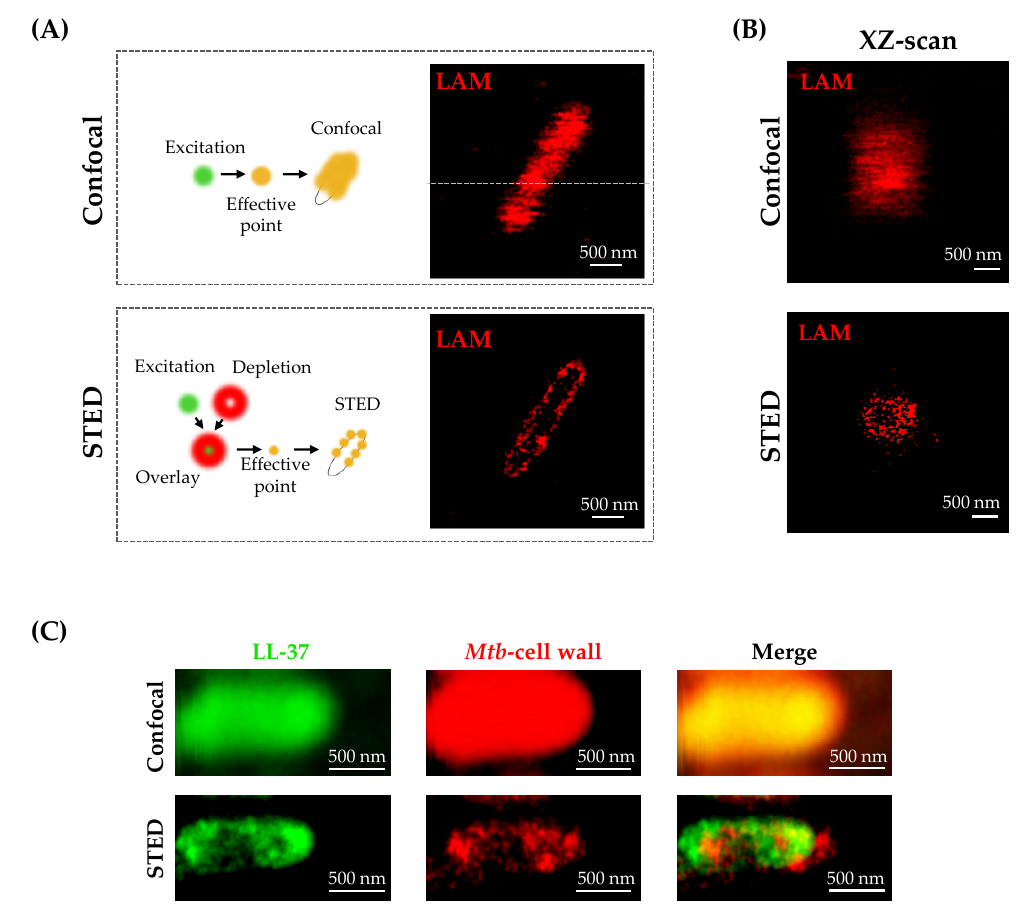
Figure 1. Comparison of Confocal and Stimulated Emission Depletion (STED) Microscopy. ( A ) Schematic visualization of the di ff erence between conventional confocal imaging and STED microscopy (left). Extracellular Mycobacterium tuberculosis ( Mtb ) was stained against the cell wall component lipoarabinomannan, followed by imaging of the same bacteria with confocal microscopy (top) and STED microscopy (bottom). Shown is one representative image of ten examined extracellular Mtb per independent experiment (n = 5). ( B ) A XZ-scan (along the dotted white line shown in ( A ) of the same lipoarabinomannan (LAM) labelled bacterial cell is shown in confocal and STED mode. Scale bar is 500 nm. ( C ) Dual color experiment of extracellular Mtb . Extracellular Mtb was labelled with fluorescein succinimidyl ester Atto 647N and incubated with LL-37-TAMRA for 5 min. Image shows LL-37-TAMRA (green), extracellular Mtb (red) and merged channels for confocal microscopy (top) and STED microscopy (bottom). Depicted is one representative image of a single extracellular Mtb out of ten examined bacteria per independent experiment (n = 3). Images were first acquired in confocal mode, followed by STED imaging with a pixel dwell time of 300 µ s and a pixel size of 20